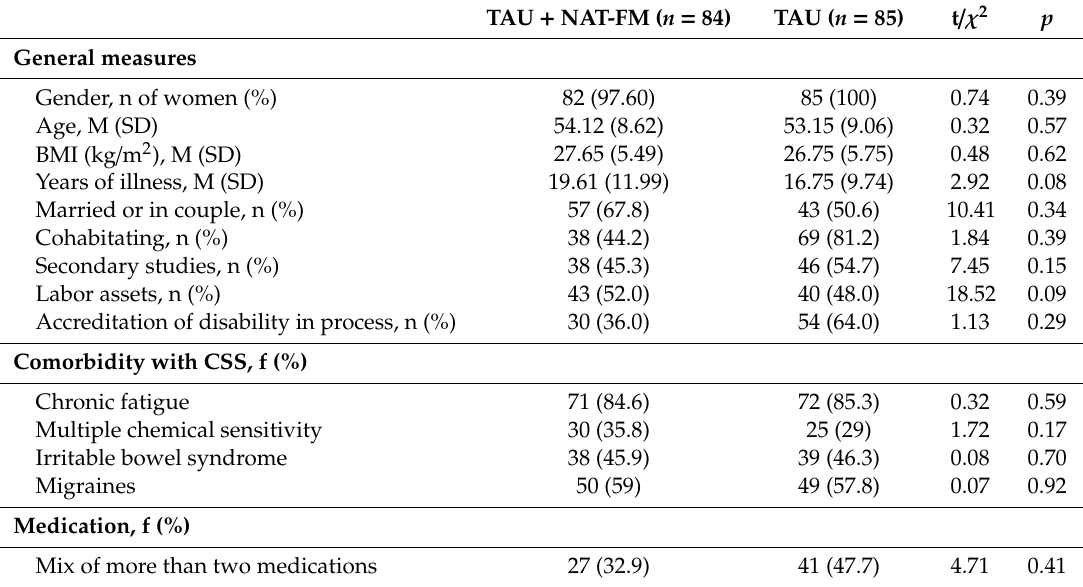
Table 3. Demographic characteristics of treatment as usual (TAU) + NAT-FM and TAU